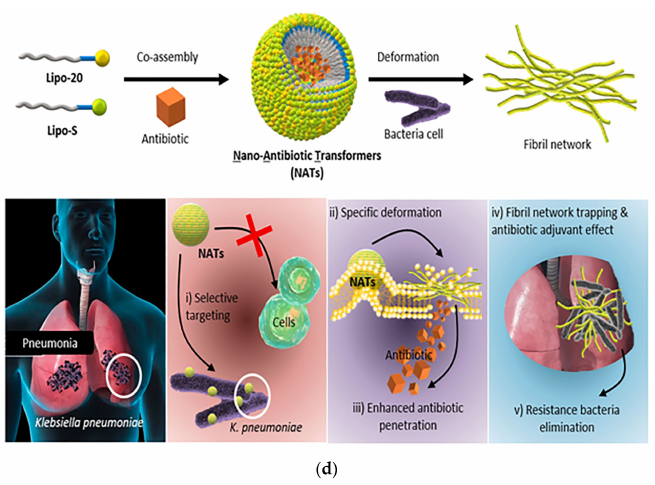
Figure 9. ( a ) Schematic of the mechanism of antibacterial action of bio-nanoparticles that self- assembled to form nanofibers to surround bacteria. The HDMP mimics the HD6 that (2) in situ self- assembly on the microbial surface through ligand-receptor interactions to form (3) a self-assembled trapping fiber network to inhibit microbial invasion. Unlike HD6, which is (1) secreted in situ from Paneth cells, HDMP is (1 (cid:48) ) delivered to the target region in the form of nanoparticles (NP). Adapted with permission from [118], Copyright 2020 American Association for the Advancement of Science. ( b ) Schematic representation of the molecular structure and self-assembly process of peptide nanoparticles. ( c ) Schematic of the in vivo sterilization mode of peptide self-assembled nanoparticles. LPS: lipopolysaccharide; OM: outer membrane; CM: cytoplasmic membrane. Adapted with permission from [119], Copyright 2022 John Wiley and Sons. ( d ) The principle of co-assembly of NATs and bacterially induced morphological transformation. Adapted with permission from [120], Copyright 2022